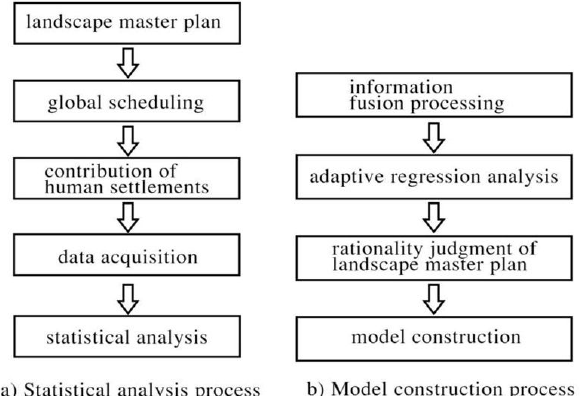
Figure 2: Implementation process of landscape